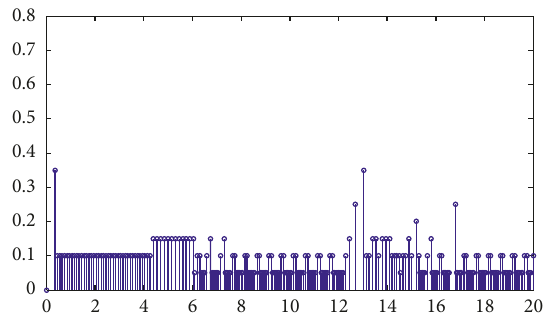
Figure 5: Response curve of state x